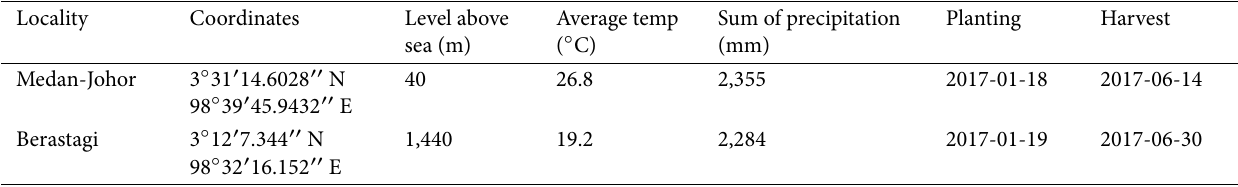
Table 1 Selected annual weather conditions in Medan-Johor and Berastagi locations. Locality